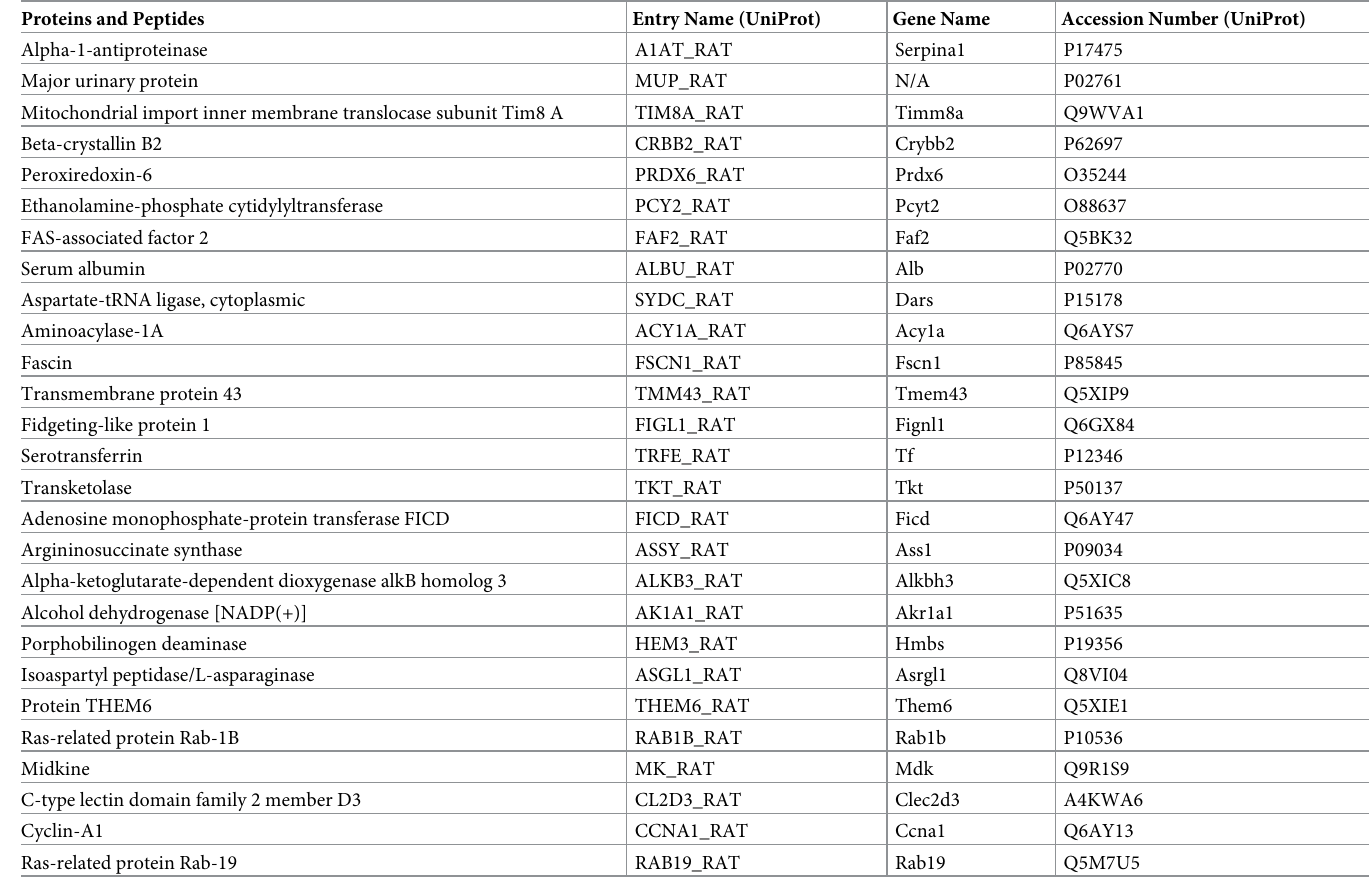
Table 5. Proteins belonging to rat kidney tissues detected from preservation